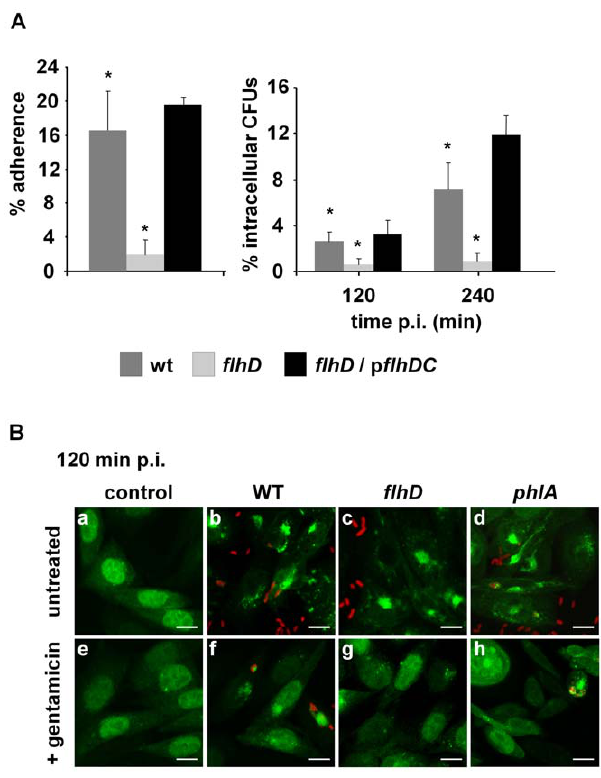
Figure 10. S. marcescens flagellum expression is involved in adhesion to CHO cells. A) CHO cells were infected for 60 min with S. marcescens wild-type, flhD and flhD/ p flhD strains (dark gray, light gray or black bars, respectively). Cells were washed with PBS and lysed with 0.05% Triton X-100 (left graphic); or incubated 120 o 240 min p.i with medium supplemented with gentamicin to eliminate extracellular